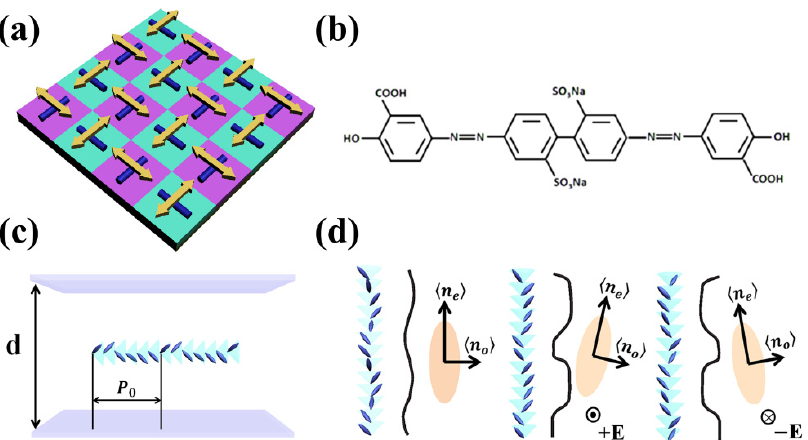
Figure 1. ( a ) SD1 with ( b ) its formula, providing the alignment direction perpendicular to the expo- sure polarization of the incident light. ( c ) Structure of a DHFLC cell and the rotating directions of the FLC molecules with external electric field. ( d ) Birefringence mechanism of